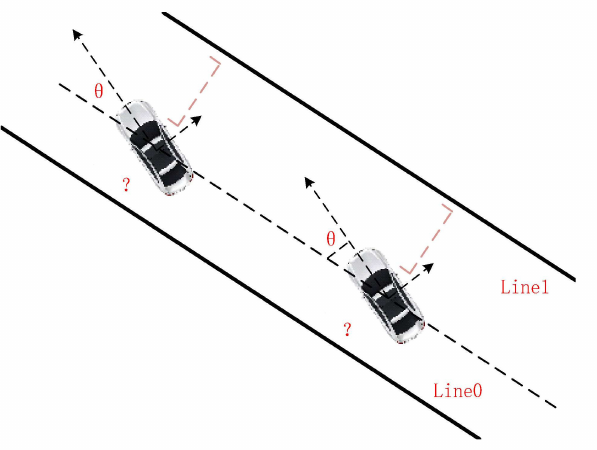
Figure 2. Representing map information that is difficult to use directly through directed graphs.